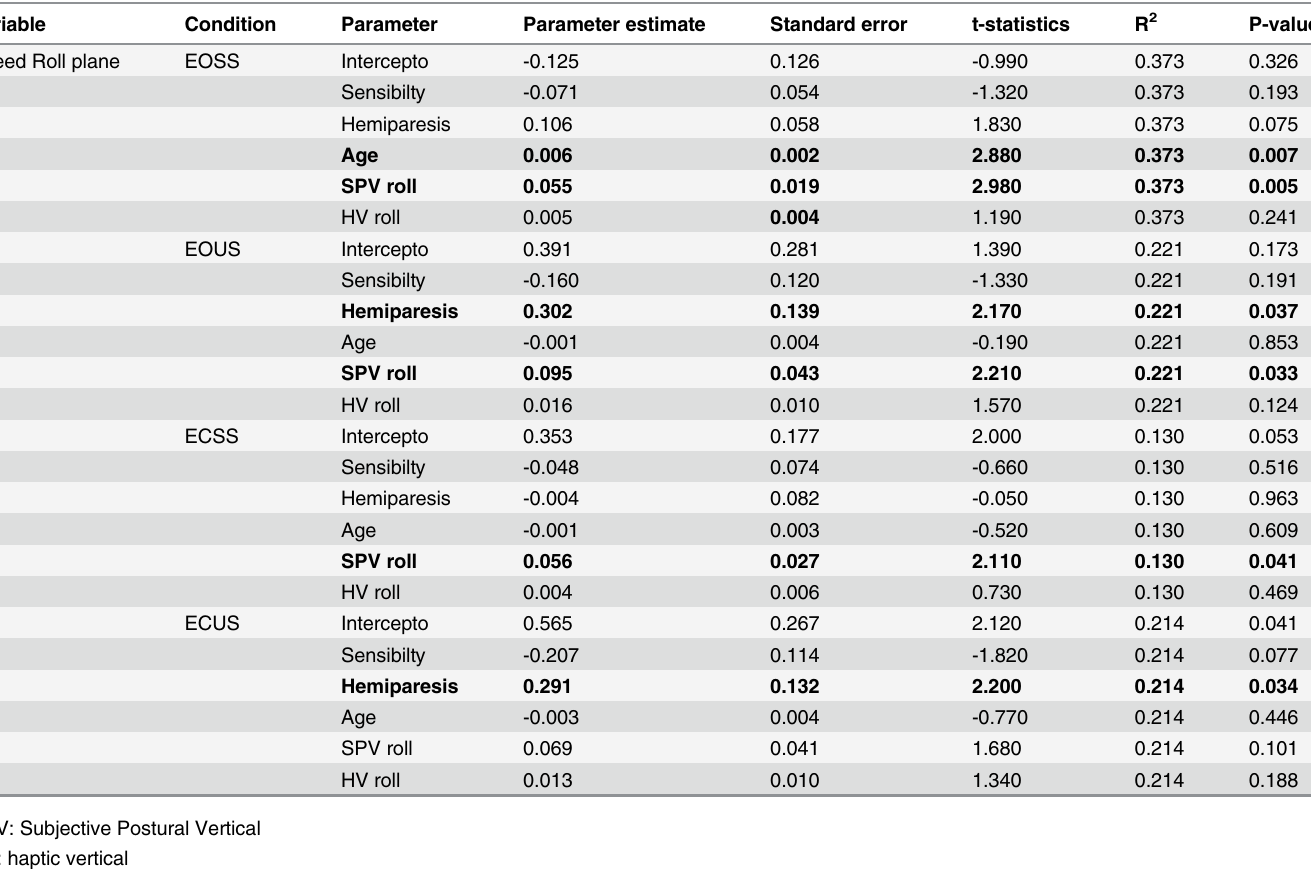
Table 5. Results from linear regression model between speed at sitting position and SPV in the roll plane.